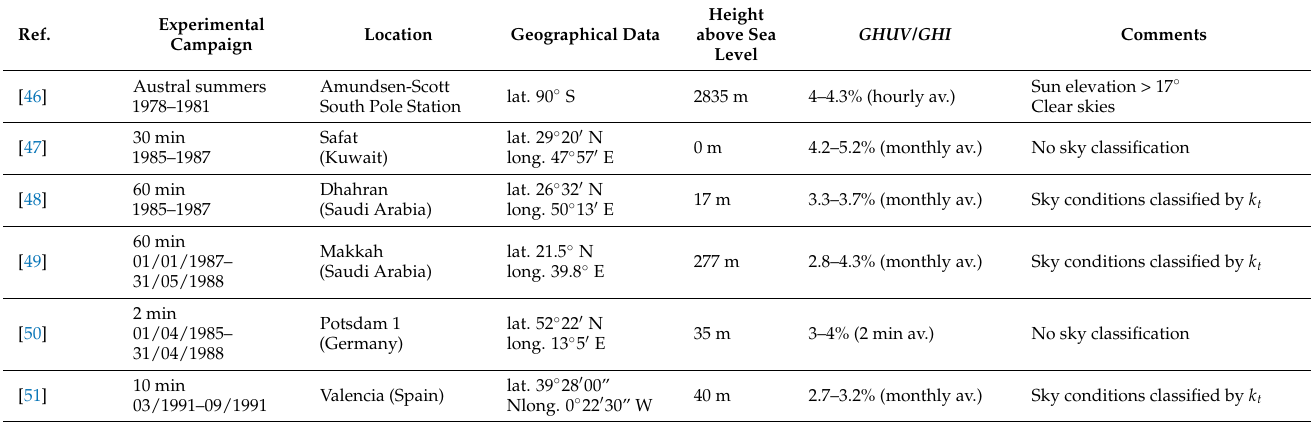
Table 1. Experimental measurements of the GHUV : GHI ratio around the